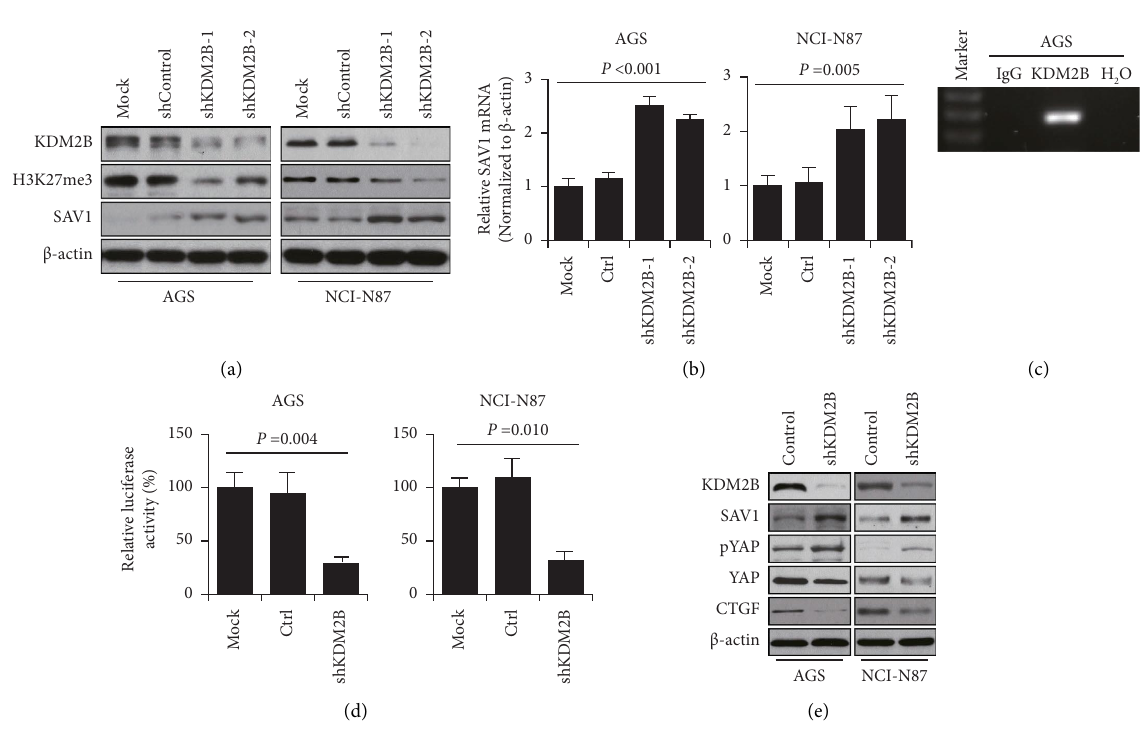
Figure 4: KDM2B transcriptionally regulates SAV1 expression. (a) KDM2B shRNAs and control vectors were transfected with AGS and NCI-N87 cells. Western blotting was used to analyze the expression of KDM2B, H3K27me3, and SAV1. β -Actin acted as the internal control. (b) AGS and NCI-N87 cells were transfected with KDM2B shRNAs and control vectors. Reverse transcription-quantitative PCR was performed to analyze the mRNA levels of SAV1. (c) Chromatin was isolated from AGS cells. Te binding of KDM2B and negative control water to the SAV1 promoter was determined using chromatin immunoprecipitation. (d) Constructions of SAV1 promoter re- porters. AGS and NCI-N87 cells were cotransfected with 0.2 µ g SAV1 promoter luciferase constructs pLuc-SAV1 and 0.2 µ g KDM2B shRNA or control vectors. Promoter activity was examined using the dual luciferase assay kit. ∗ P < 0 . 05. (e) AGS and NCI-N87 cells were transfected with shKDM2B and control vectors. Te levels of SAV1, p-YAP, YAP, and CTGF were analyzed via western blotting. β -Actin acted as the internal control. SAV1, Salvador homologue 1; shRNA, short hairpin RNA; KDM2B, lysine-specifc demethylase 2B; YAP, yes- associated protein; CTGF, connective tissue growth factor; p